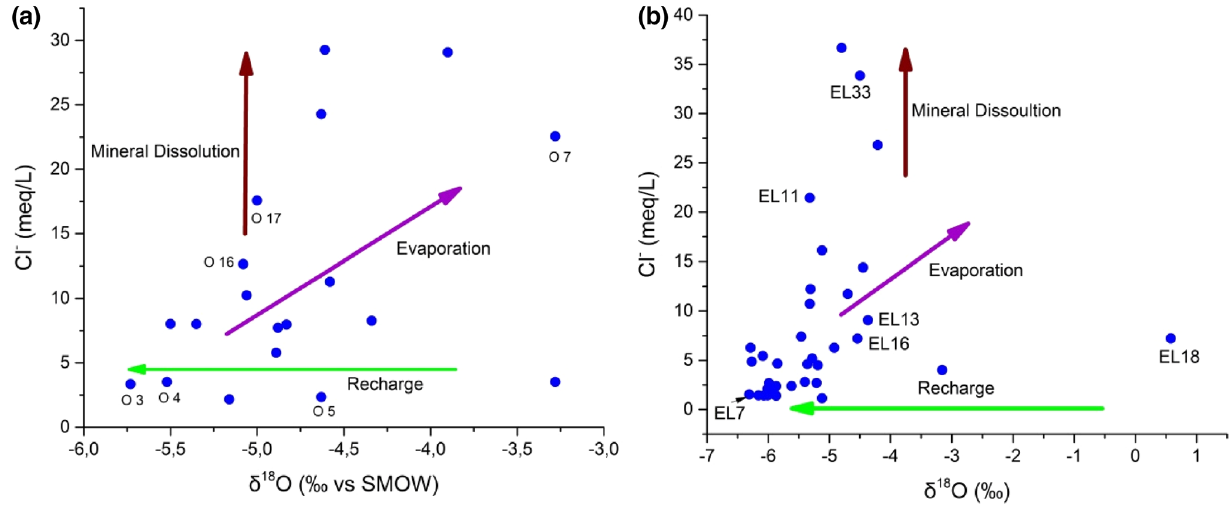
Fig. 10 Plot of Cl − vs δ. 18 O for the groundwater for the campaign 2016 ( a ) and the campaign 2020 ( b